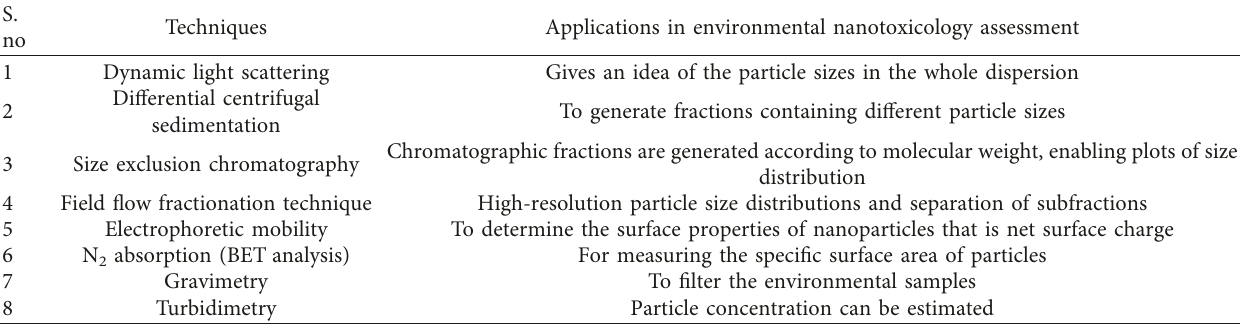
Table 1: Techniques used for the characterisation of nanomaterials in environmental samples.